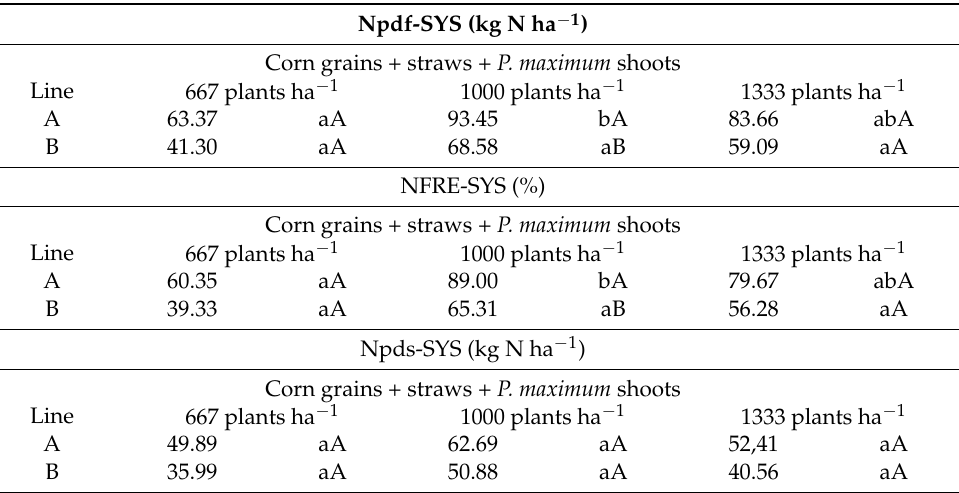
Table 3. Total nitrogen in the plant derived from fertilizer (Npdf-SYS), N fertilizer recovery efficiency (NFRE-SYS) and N in the plant derived from soil (Npds-SYS) in corn grains, straws and in P. maximum shoots representing the amount of N accumulated in agrisilviculture systems with 667, 1000 and 1333 plants of Gliricidia sepium ha − 1 . Corn straws and grains and Panicum maximum shoots were collected at lines close to the G. sepium plants (A) and in the middle of the plots